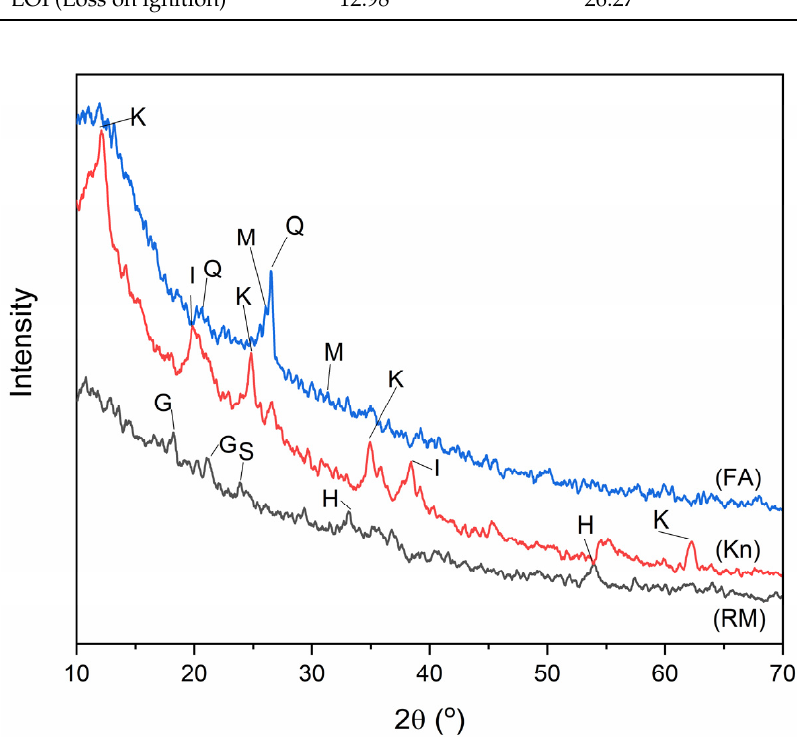
Figure 1. XRD diffractograms of red mud (RM), kaolin (Kn), and fly ash (Fa) (Q: quartz; M: mullite; K: kaolinite; I: illite; H: hematite; S: sodalite; G: gibbsite).